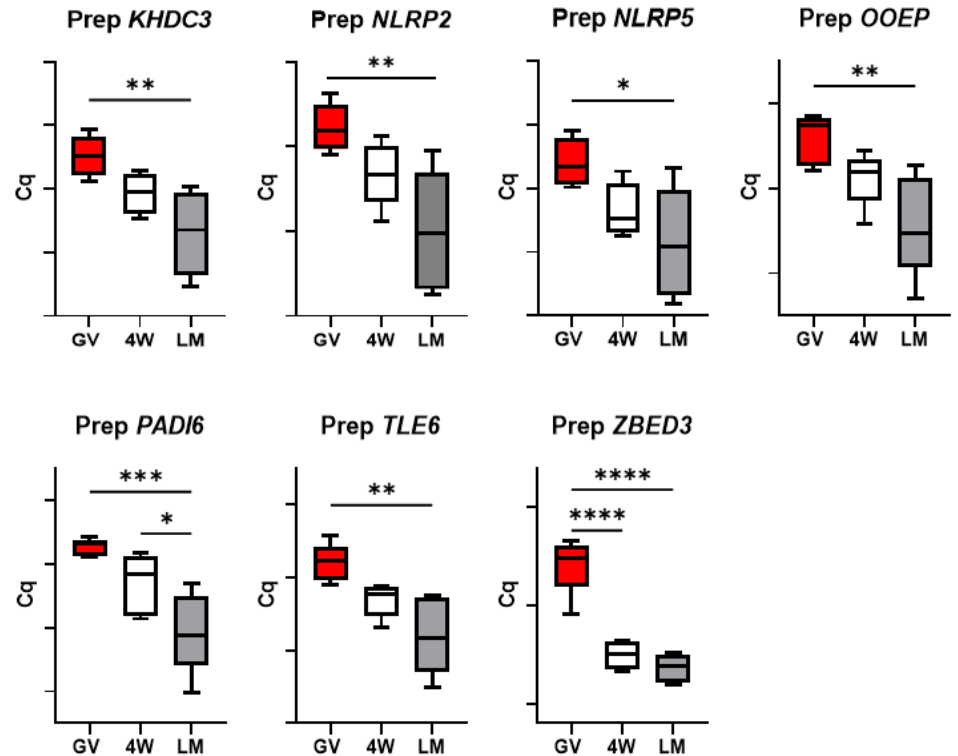
Figure 2. Expression of the subcortical maternal complex (SCMC) components in pools of prepubertal GV and MII oocytes matured in 4-well plates (4W) or in liquid marbles (LM). Target gene expression was normalized against the luciferase exogenous control. Relative abundance is expressed as ∆ Cq ( Y - axis). Each box represents the mean expression of 4–6 replicate pools of 10 oocytes each (mean ± SE). Significant differences were assessed by ANOVA general linear model test; * p < 0.05, ** p < 0.01, *** p < 0.001, **** p < 0.0001.